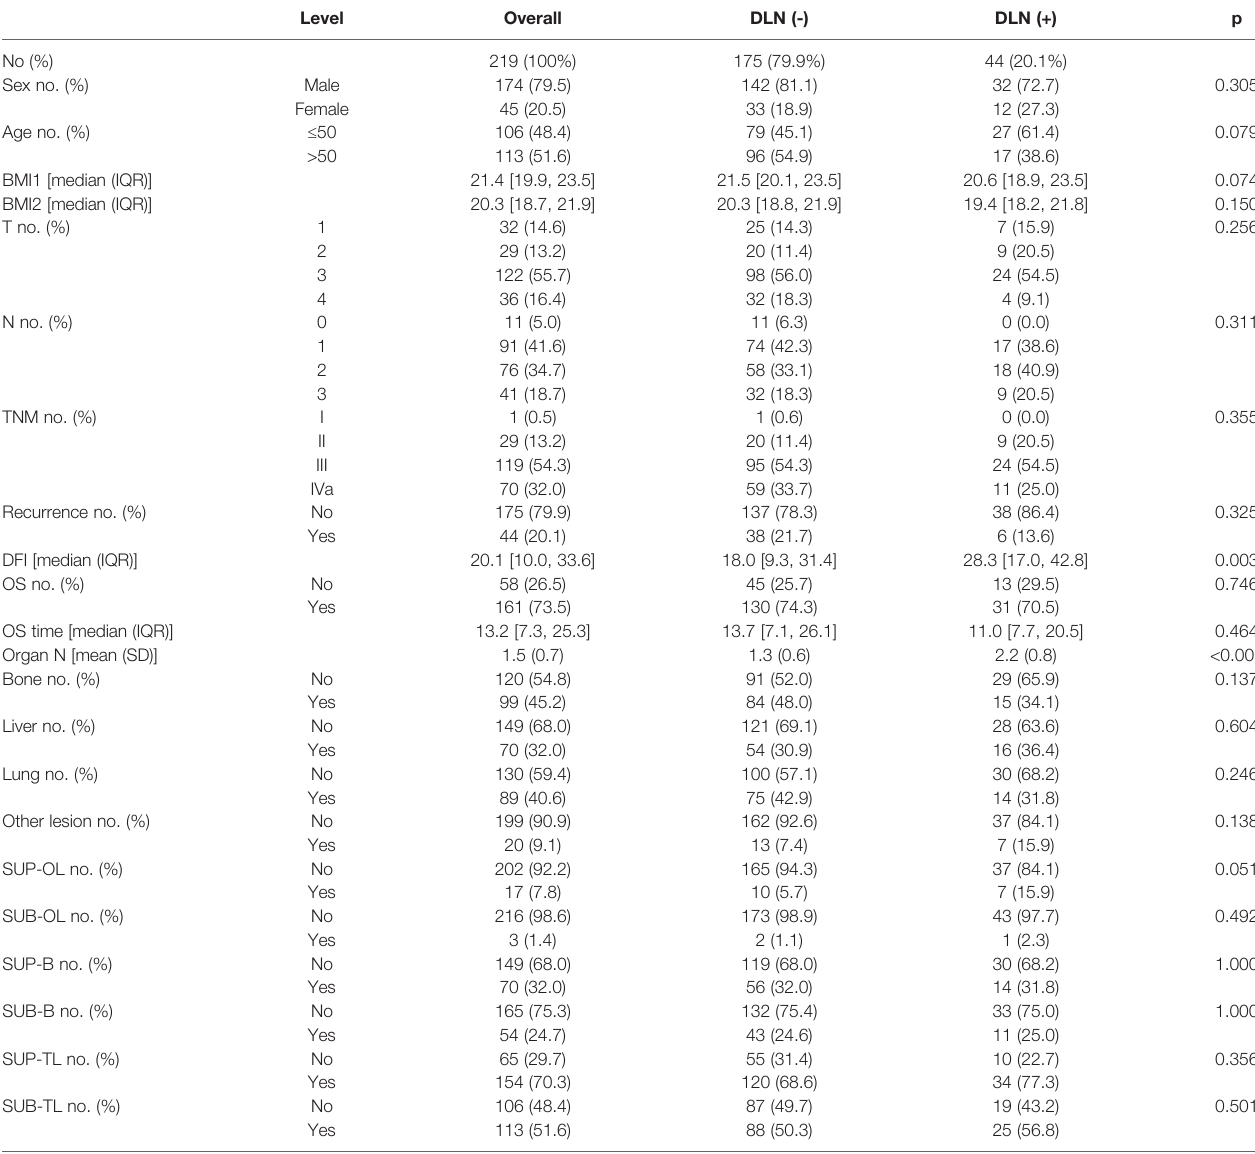
TABLE 1 | Patient characteristics.